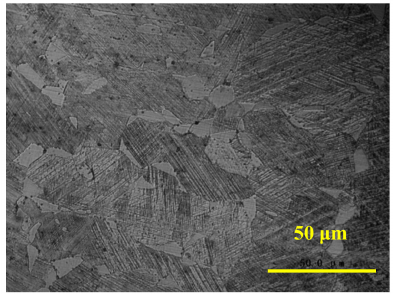
Figure 3. Microstructure of Fe-Mn-Si SMAs welding seam.